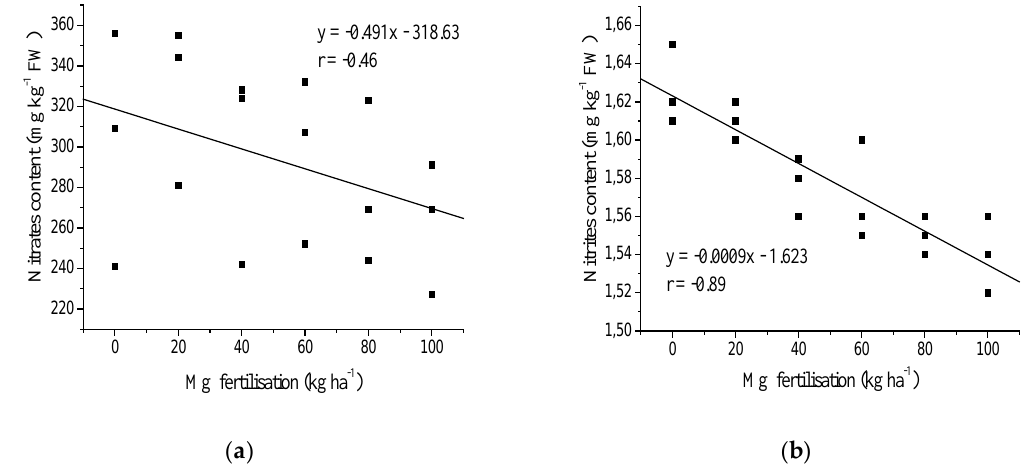
Figure 5. The significant relationship between the dose of magnesium fertilisation and NO 3 ˉ (a) and NO 2 ˉ (b) contents in the potato tubers after 3 months of storage. R: p ≤ 0.05.